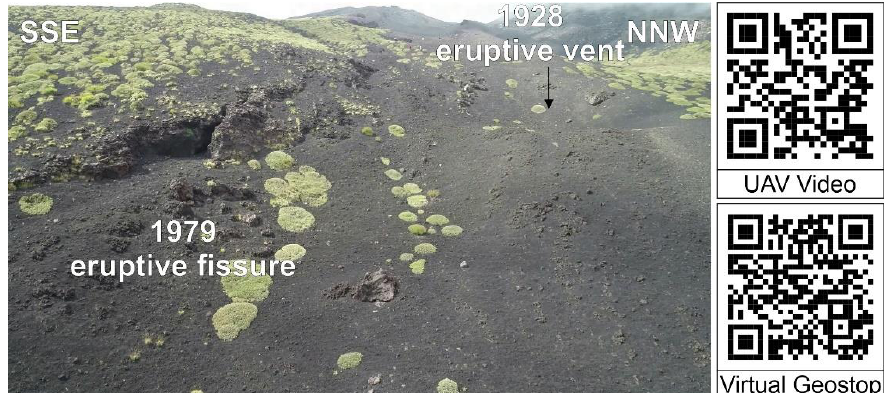
Figure 3. The image on the left shows geostop 1 through a WSW-looking UAV-captured picture. The QR codes on the right enable opening the corresponding UAV-captured video and the related VG. By using a mobile phone or a tablet, open up the QR code reader. Hold your device over the QR code, so that it is clearly visible on your screen. Press the notification and wait a few seconds.